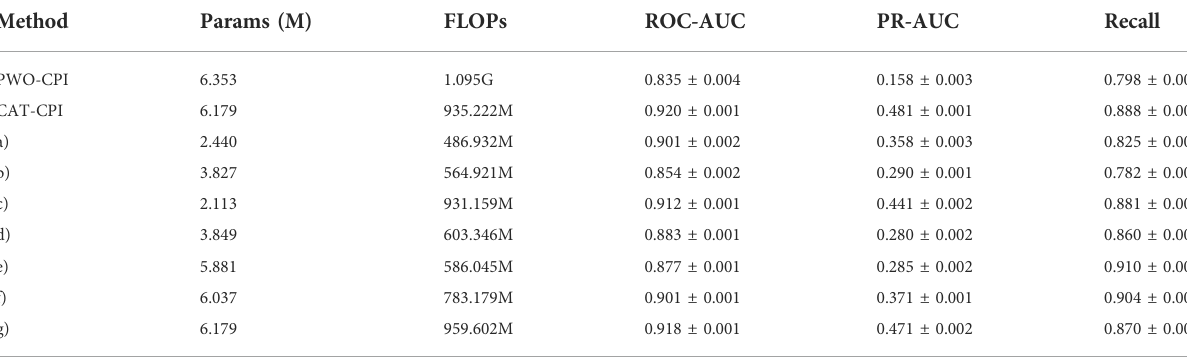
TABLE 8 Results of model parameters and computational quantities ablation experiments on the Davis